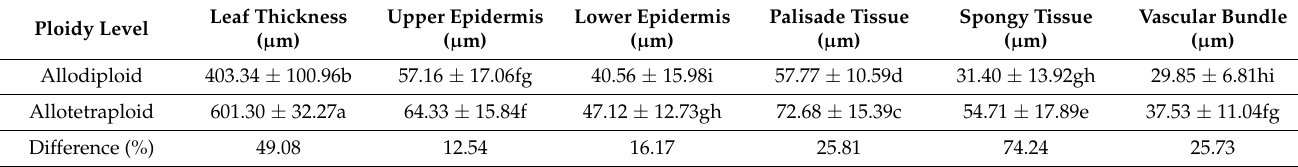
Table 2. Leaf anatomical structure of allodiploid and allotetraploid Lilium FA hybrids.